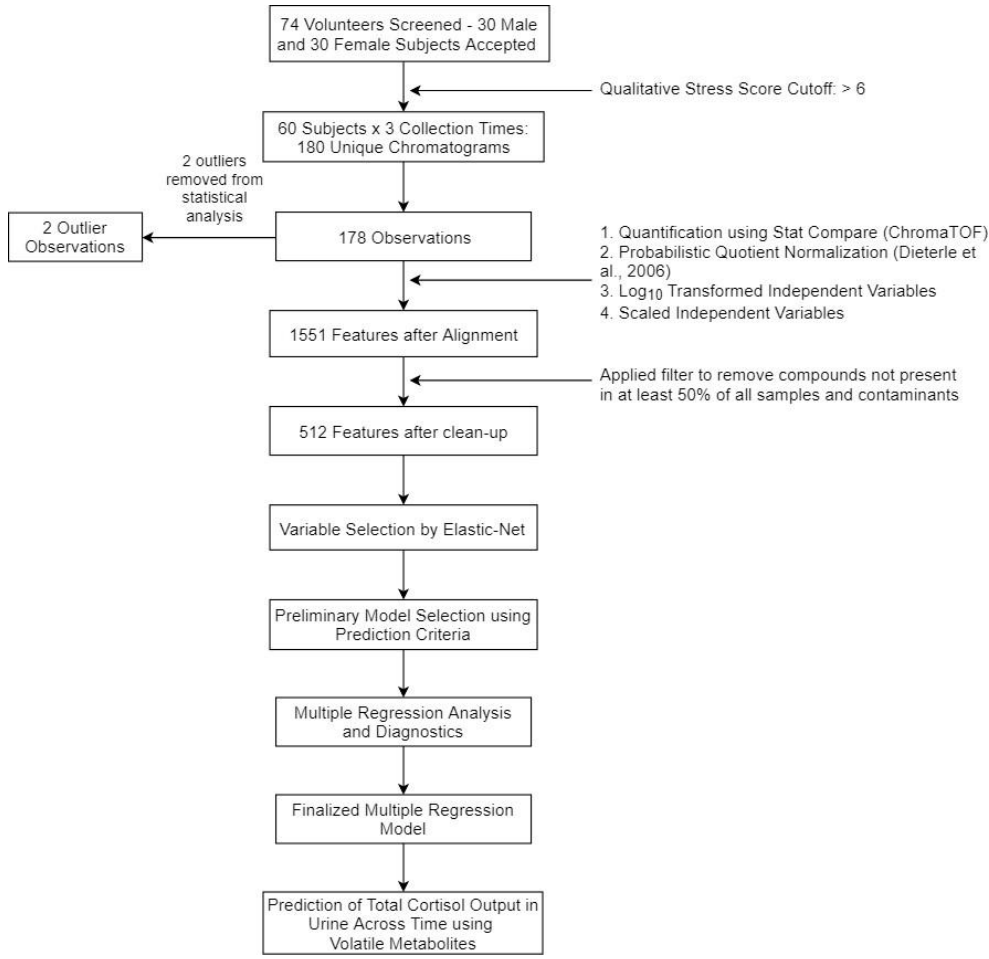
Figure 4. Flowchart showing the process for urinary metabolome identification and statistical analyses.